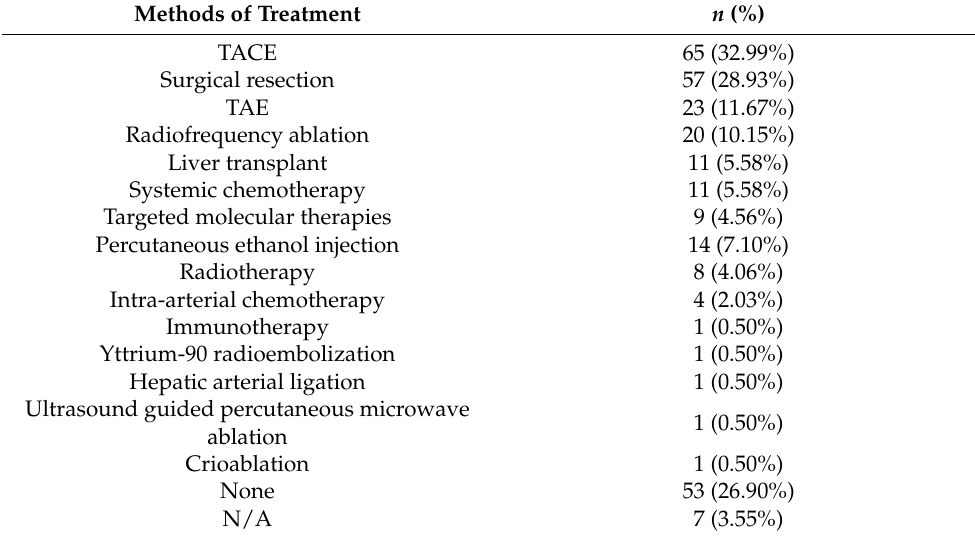
Table 5. Previous treatment of